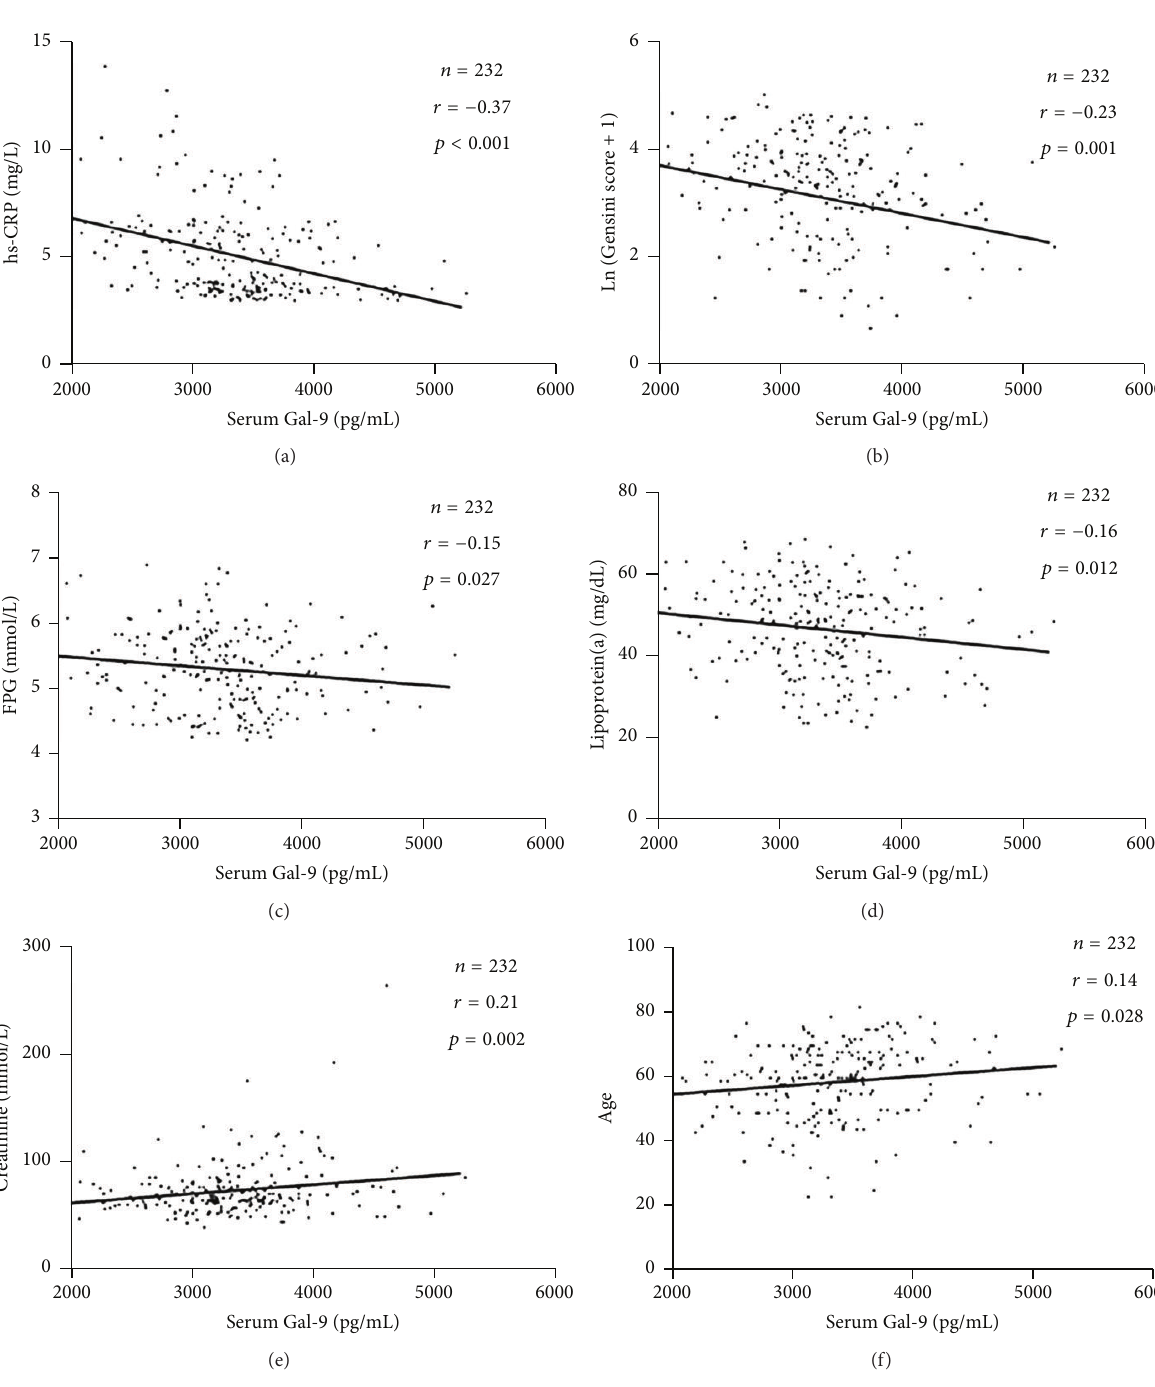
Figure 5: Spearman’s correlation of Gal-9 levels with anthropometric and biochemical variables. Gal-9 levels were found to be negatively correlated with hs-CRP (Figure 5(a)), the Gensini score (Figure 5(b)), FPG (Figure 5(c)), and lipoprotein(a) (Figure 5(d)) but positively associated with creatinine (Figure 5(e)) and age (Figure